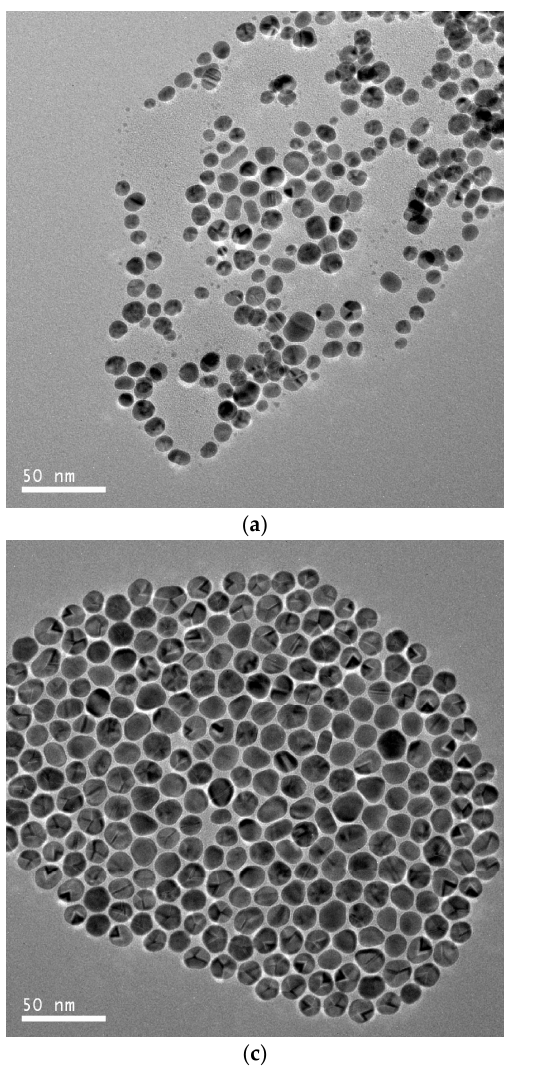
Figure 3. TEM images of the hydrophobic gold spherical nanoparticles resulting from the growth of seed gold nanodots at growth/seed ratios = 2:1 ( a ); 4:1 ( b ); 6:1 ( c ); and 8:1 ( d ).